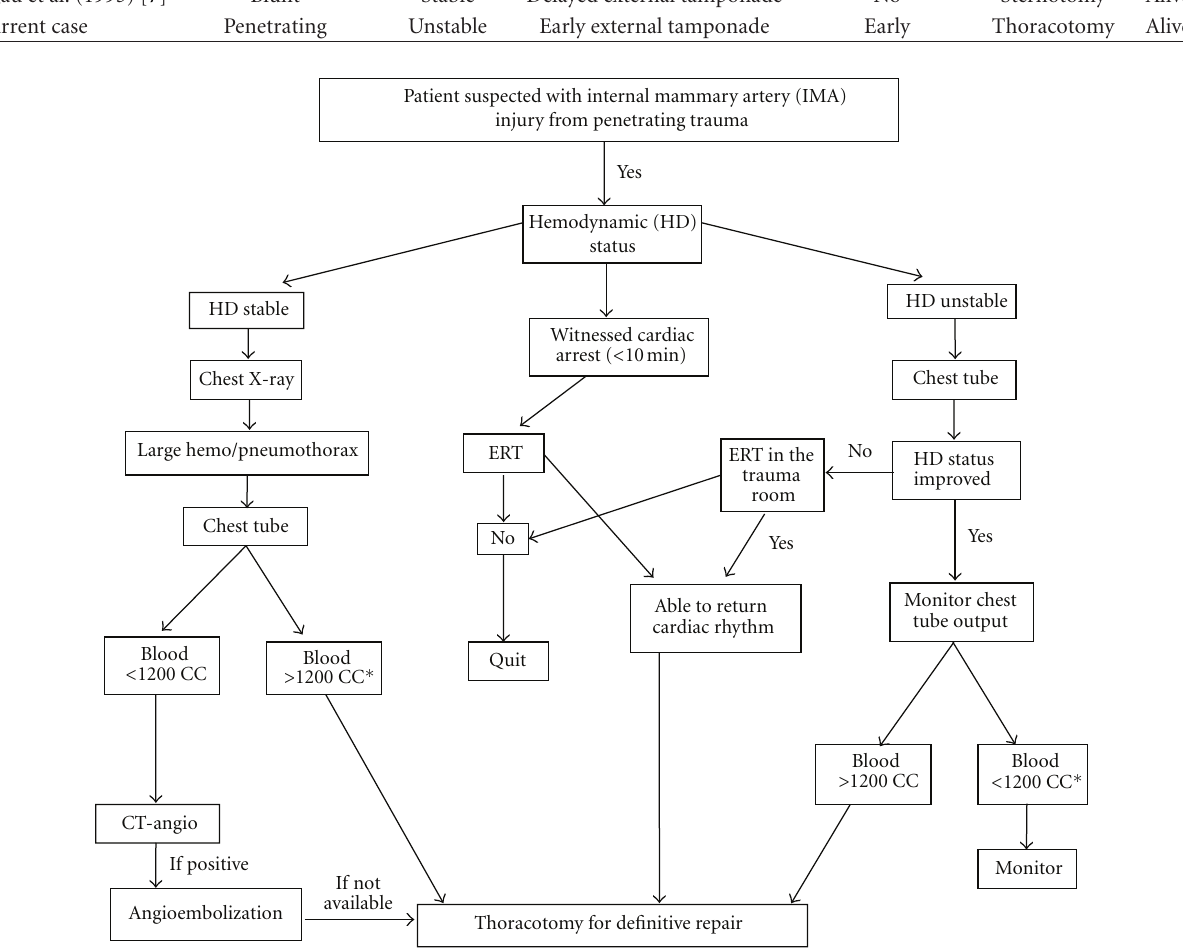
Figure 1: Algorithm approach for suspected internal mammary artery (IMA) injury. Although current resuscitation by thoracotomy is bleed > 1500CC, we believe that if > 1200 CC the patient should undergo thoracotomy. IMA: Internal mammary artery, ERT: Emergency resuscitative thoracotomy (courtesy from Rifat